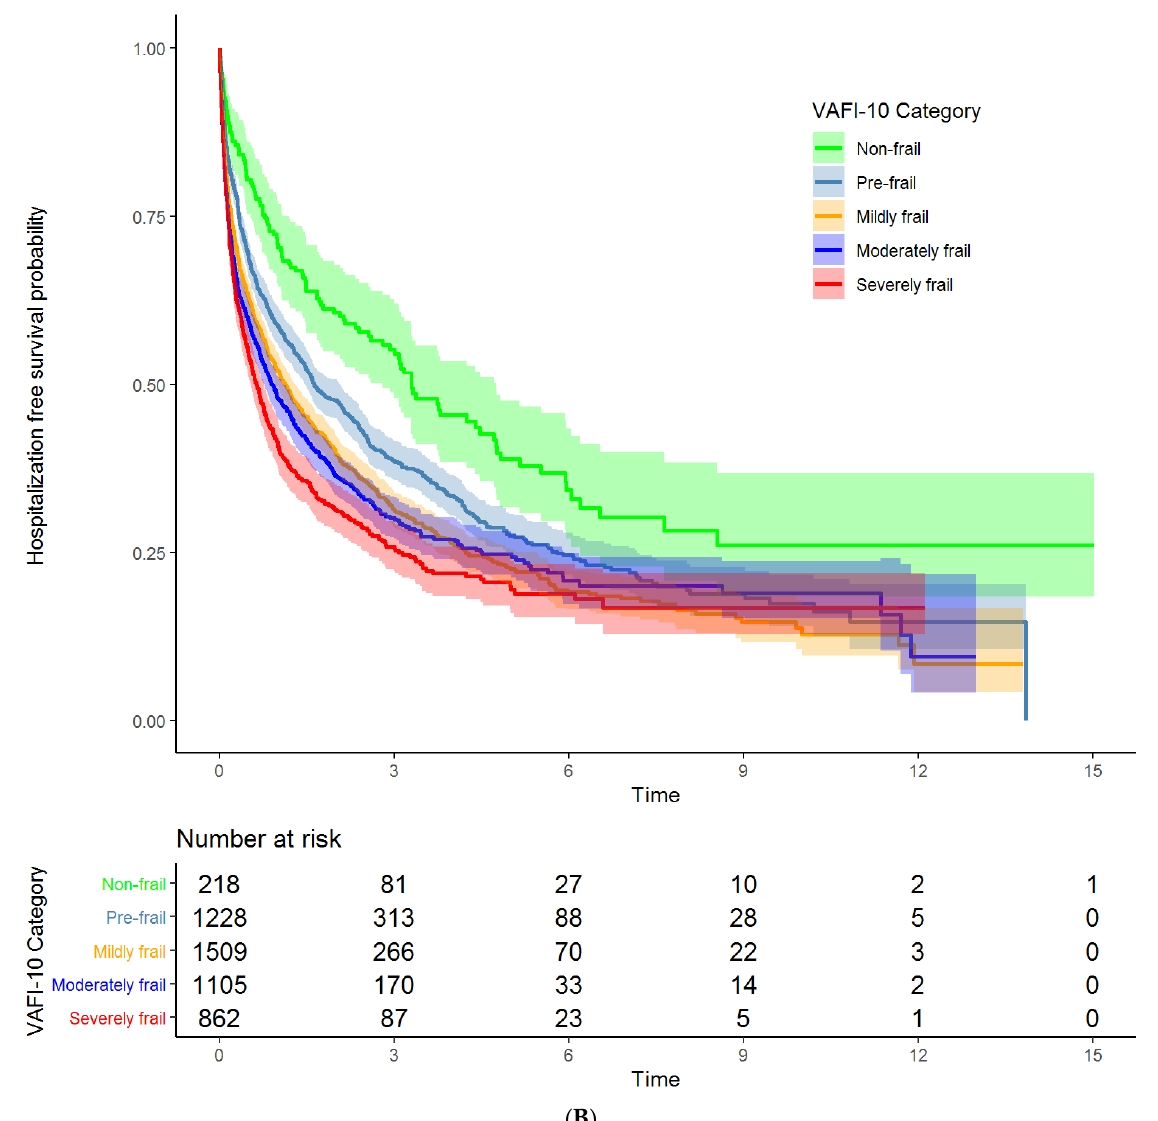
Figure 3. Kaplan–Meier curves demonstrating time (in years) to death ( A ) and time (in years) to hospitalization ( B ) by VA-FI-10 severity. Log-rank test p -value < 0.001 for both analyses.